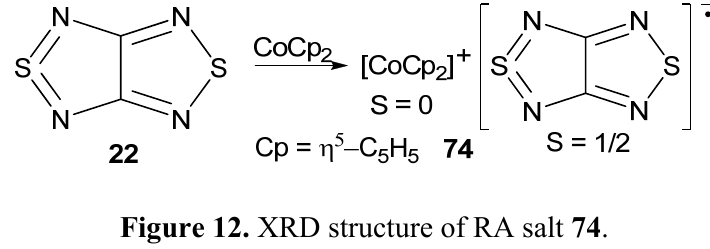
Figure 12. XRD structure of RA salt 74